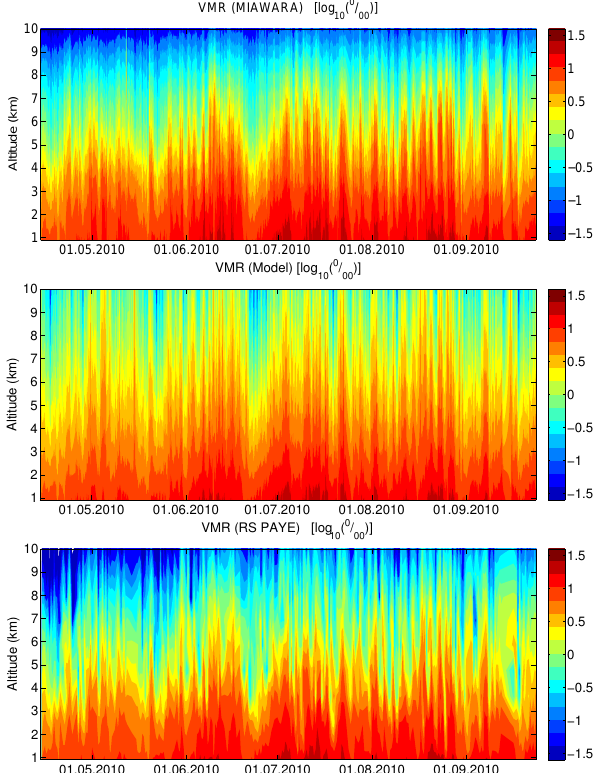
Fig. 9. H 2 O vmr retrieved from MIAWARA (4h averaged spectra, top plot), modelled using the surface value from Zimmerwald me- teo station and MIAWARA-opacity (center plot) and H 2 O vmr from Payerne soundings regridded to MIAWARA-grid (bottom plot, ex- planations in